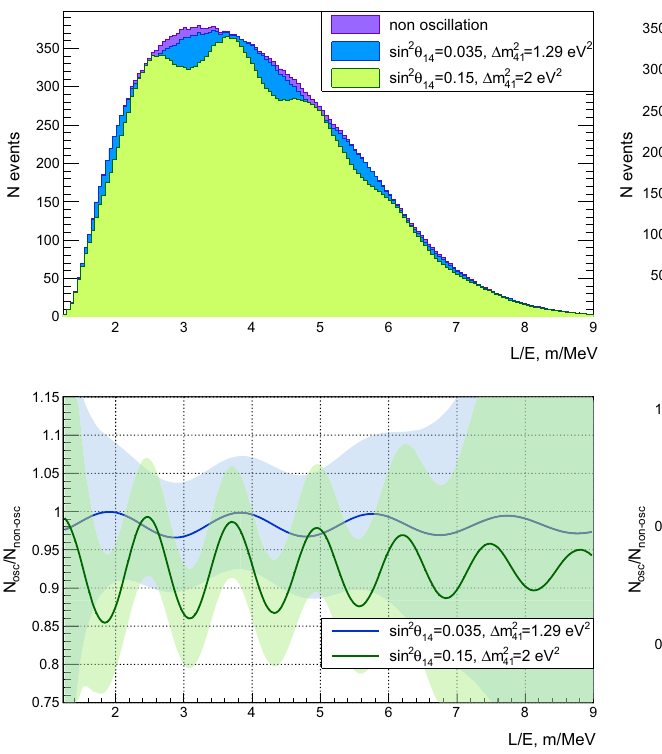
Fig. 3 The top left panel corresponds to the non-oscillation event rate and two oscillation rates with the different values of oscillation param- eters as a function of L / E variable (the right panel is for the IsoDAR case). The blue spectrum is based on current best fit values for the ster-